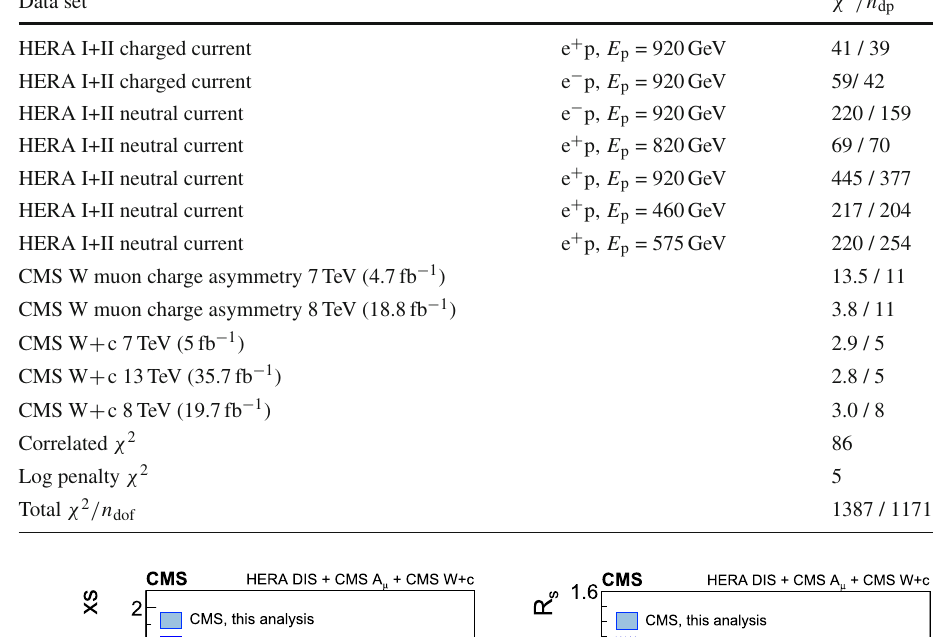
Fig. 7 The strange quark distribution (upper left) and the strangeness suppression factor (upper right) as a function of x at the factorization scale of m 2 . W The corresponding relative total uncertainties are compared in the lower plots (strange quark distribution, lower left, and strangeness suppression factor, lower right). The results from the QCD analysis, shown as a filled area, use as input the combination of the inclusive deep inelastic scattering (DIS) cross sections [71], the CMS measurements of the lepton charge asymmetry in W boson √ s = 7 and 8TeV production at [72,73], and the CMS measurements of W + c √ s = 7 [5], 8 production at (this analysis) and 13TeV [6]. The W + c measurement at √ s = 8TeV is not used for the fit shown in hatched